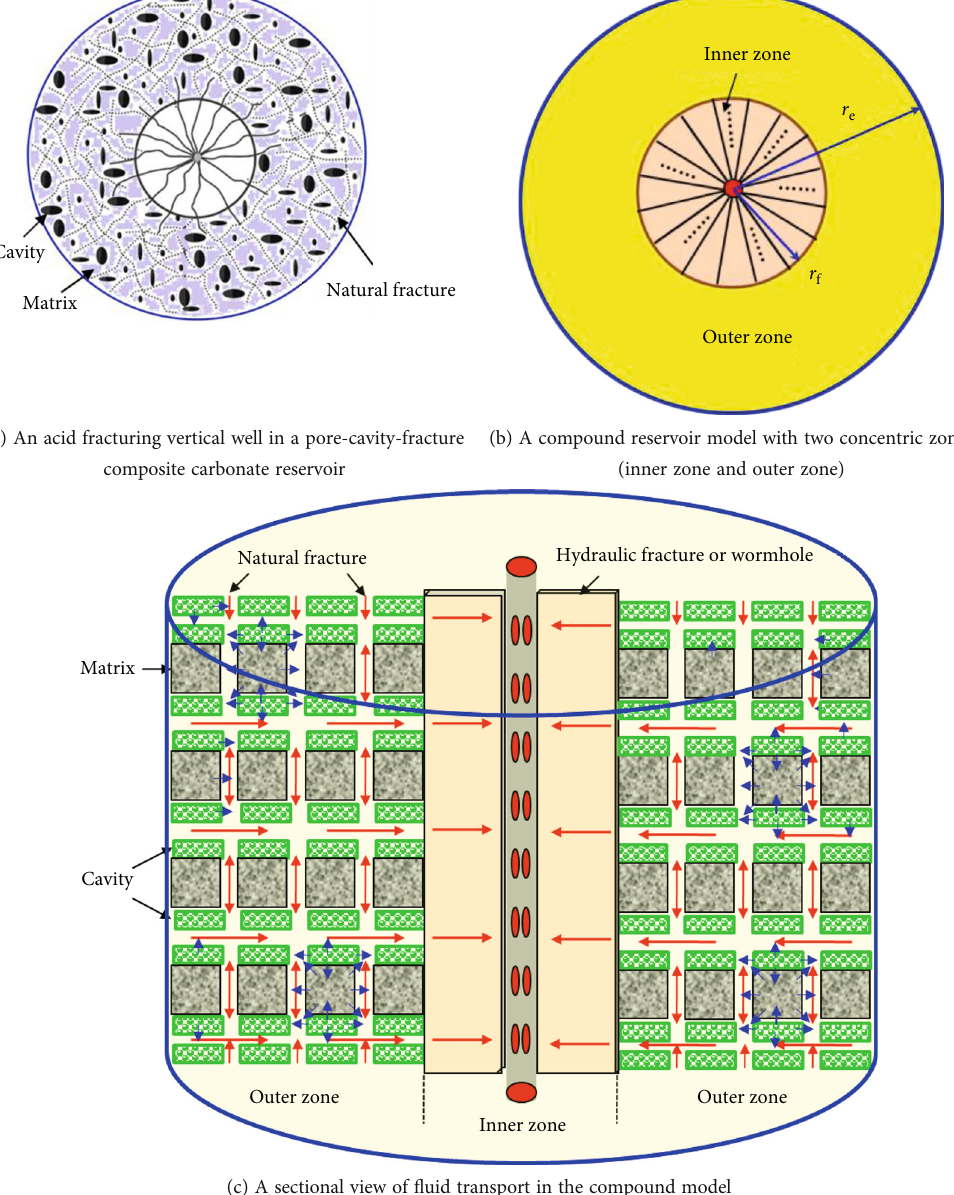
Figure 3: Schematic diagram of a compound fl ow model of acid fracturing vertical well in a pore-cavity-fracture carbonate